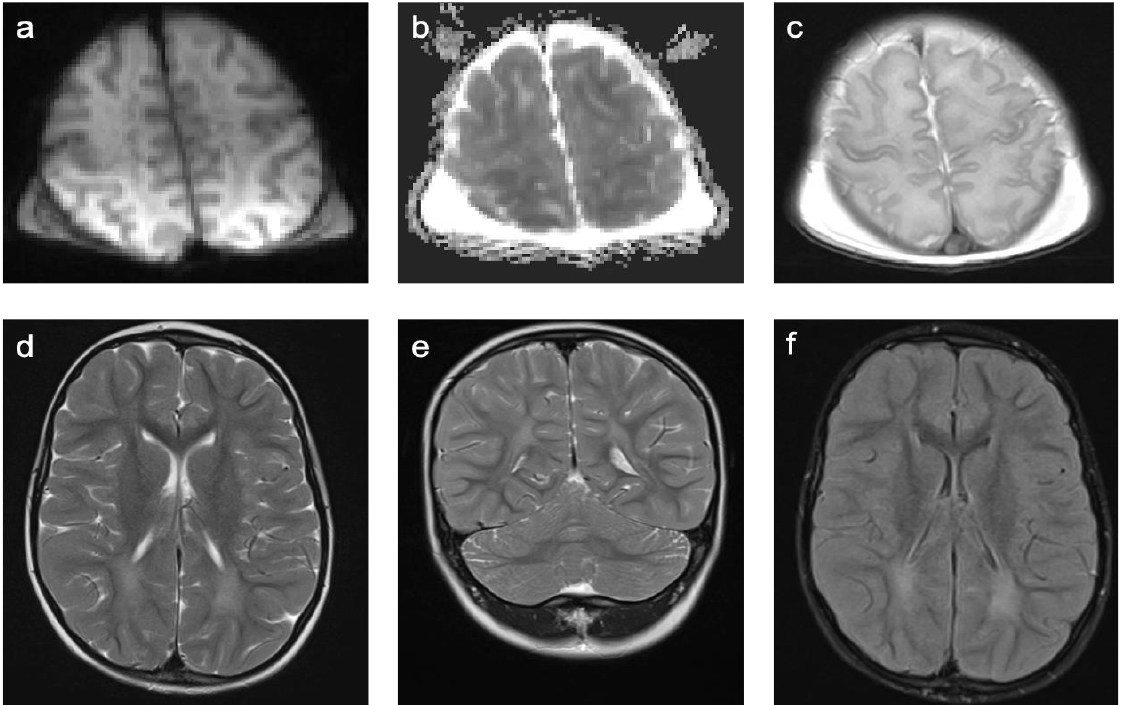
Figure 4. Representative case “Non-genetic hypoxic and ischemic insults”: term-birth asphyxia. DWI/ADC ( a , b ), T2W ( c – e ), FLAIR ( f ) sequences. Neonatal resuscitation after severe term-birth (40 weeks) asphyxia in a three-day-old girl. ( a – c ). Treatment with therapeutic hypothermia. MRI shows predominantly white matter injury as one of the patterns identified in term-birth asphyxia [20]. The same girl examined again at the age of four years ( d – f ). MRI shows periventricular signal hyperin- tensities in T2W/FLAIR sequences.